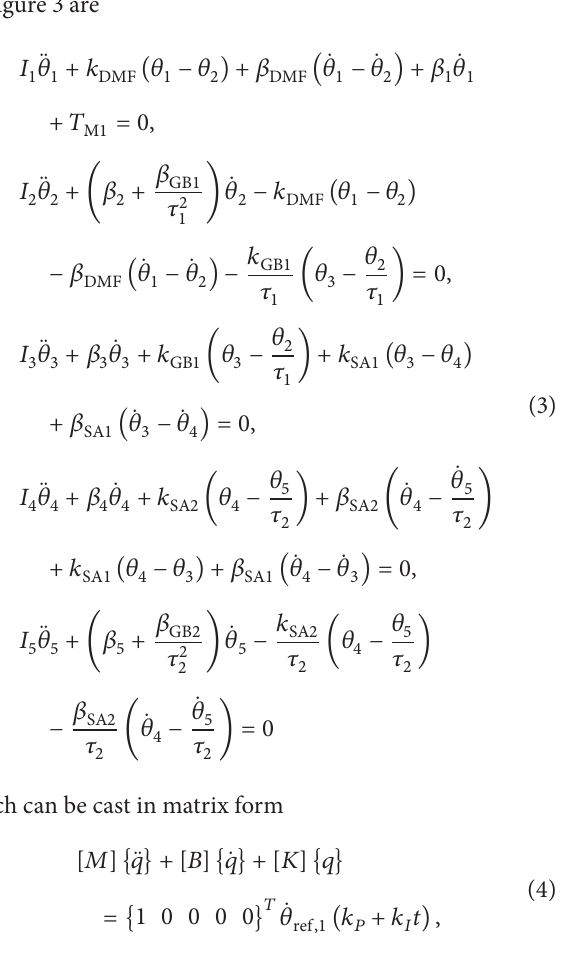
The equations of motion of the torsional system depicted in Figure 3